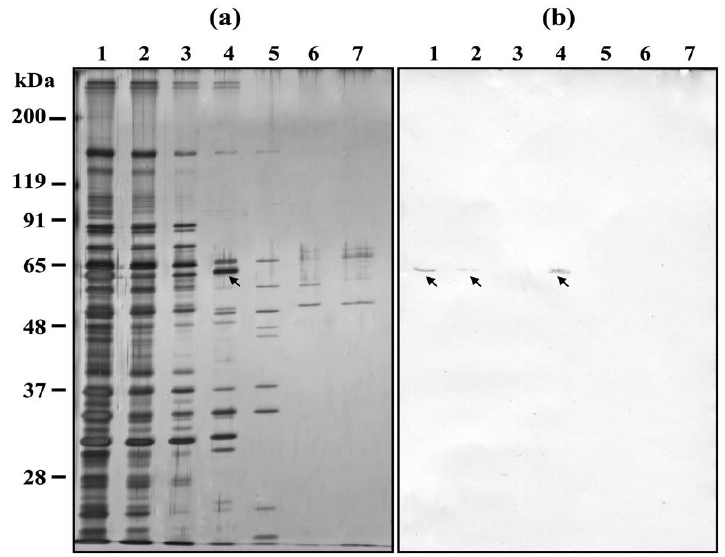
Figure 6. DNA affinity chromatography of H. obtusa IFs. P. caudatum DNA was used. ( a ) Silver stained SDS-PAGE gel; ( b ) immunoblotting with the monoclonal antibody mAb3D1B9C4 specific for the 63-kDa periplasmic protein PRP1 of H. obtusa . Lane 1, supernatant of sonicated H. obtusa before applying to DNA affinity chromatography column; lane 2, first elute of supernatant of sonicated H. obtusa after applying to the column; lane 3, first elute by elution buffer containing 0.02 M NaCl; lane 4, first eluate by 0.1 M NaCl elution buffer; lane 5, first eluate by 0.2 M NaCl elution buffer; lane 6, first eluate by 0.3 M NaCl elution buffer; lane 7, first eluate by 2 M NaCl elution buffer; arrows, PRP1. Eluates from each column were collected in every 200 µ L, and the first eluate from each column was used for SDS-PAGE and immunoblot with mAb. Note that not only PRP1 but also several silver stained bands were confirmed in lane 4 of ( a ).